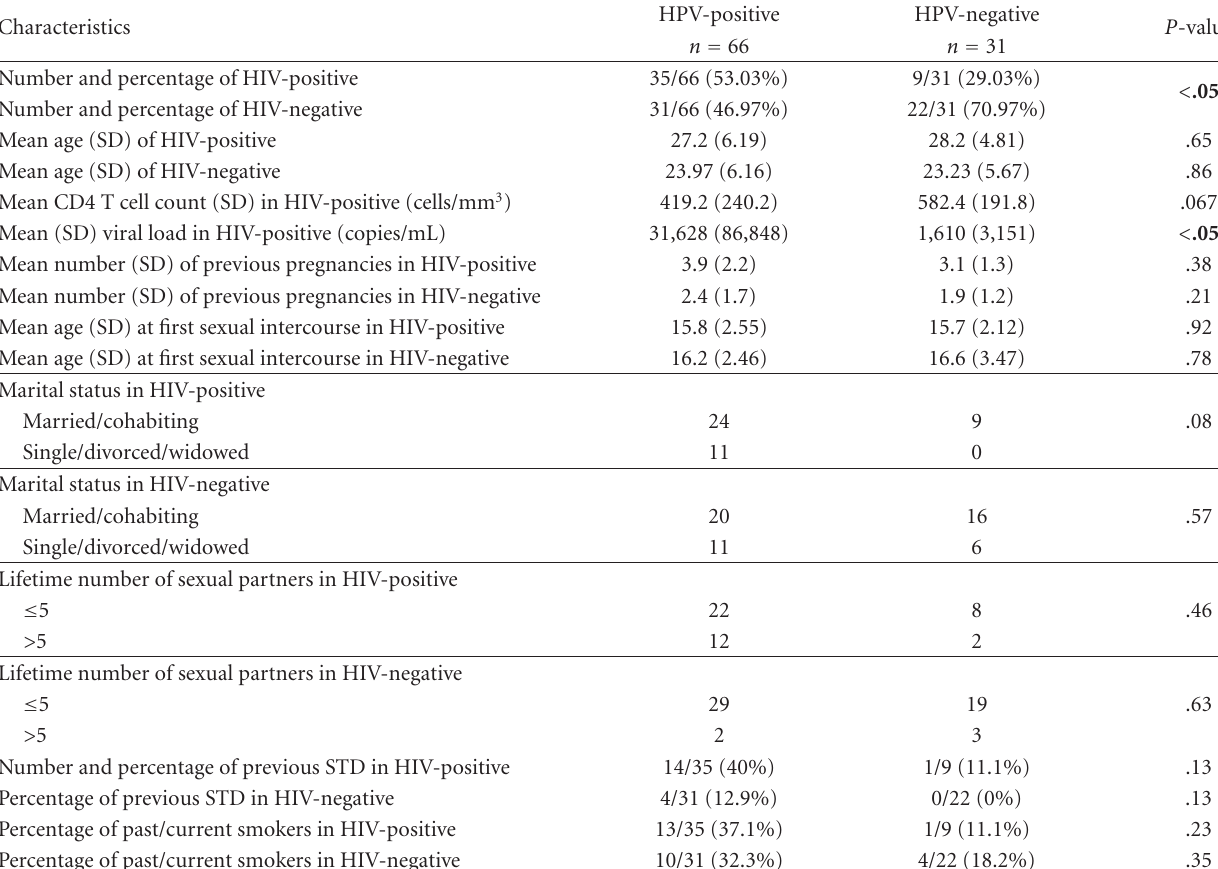
Table 1: Characteristics of participants by HPV and HIV